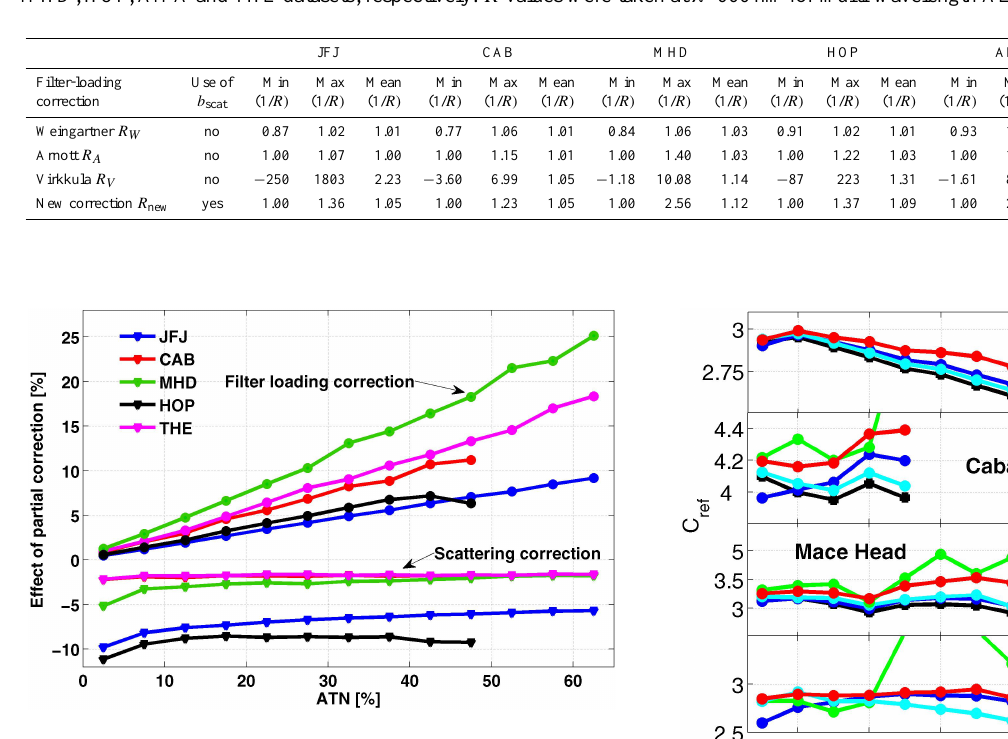
Fig. 3. Effect of the filter-loading ( • ) and of the scattering ( N ) par- tial corrections [(total correction – total correction without one par- tial correction)/total correction] as a function of the attenuation of light through the filter for 5 stations. At MHD and HOP the max- imum of the wavelength is found at 840nm, where λ =370nm is reported for multi-wavelength AE (JFJ, CAB, THE). For the THE dataset, a C ref =4.26 similar to the one of CAB was applied.